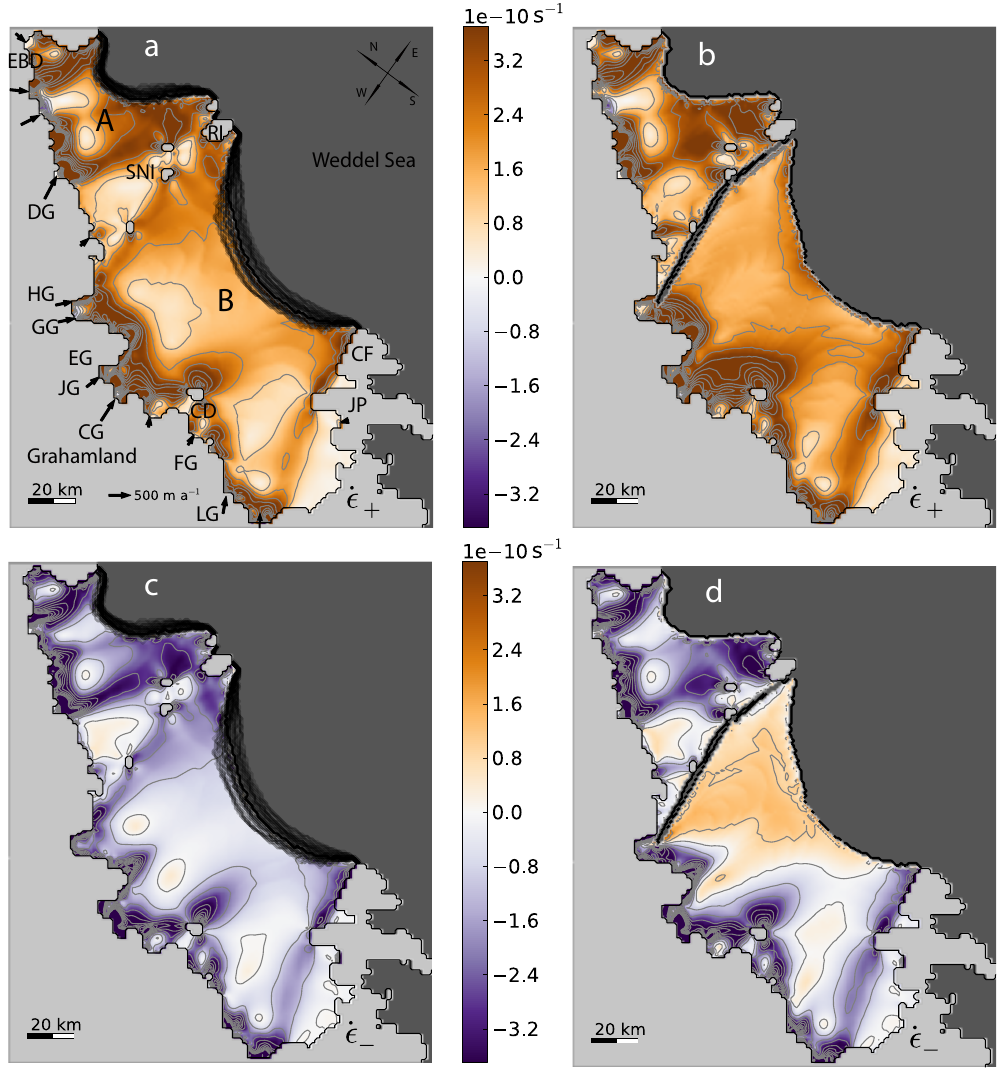
= 1 × 10 9 ma. Change in spreading-rate components in Fig. 6. Kinematic calving law applied to Larsen A and B Ice Shelves with K ± 2 eigendirections due to instantaneous introduction of ice rift of 2000 m width, which separates ice flow from its pinning points. While the spreading rate in the direction of maximum ice flow ˙ (cid:15) + ≈ ˙ (cid:15) k does not change significantly (panel a → b). Spreading rate ˙ (cid:15) − ≈ ˙ (cid:15) ⊥ changes sign near the rift (panel c → d) and thereby initiates an abrupt transition towards a second stable state as shown in Fig. 7c. Light gray shading represents grounded ice and dark gray shading represents ice-free ocean which are both not modeled here. Gray lines adjacent to the calving front represents the variability of the front in the equilibrium simulation. Time step for plotted front-front positions is two